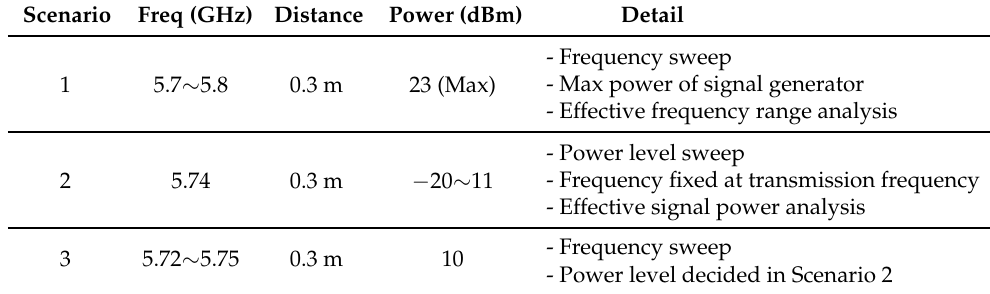
Figure 8. Experimental setup for low-power IEMI experiment on custom drone (Pixhawk 4). ( a ) Ex- perimental setup diagram; ( b ) Realized experimental setup. Table 6. Experiment scenarios of low power IEMI on camera module using analog-communication